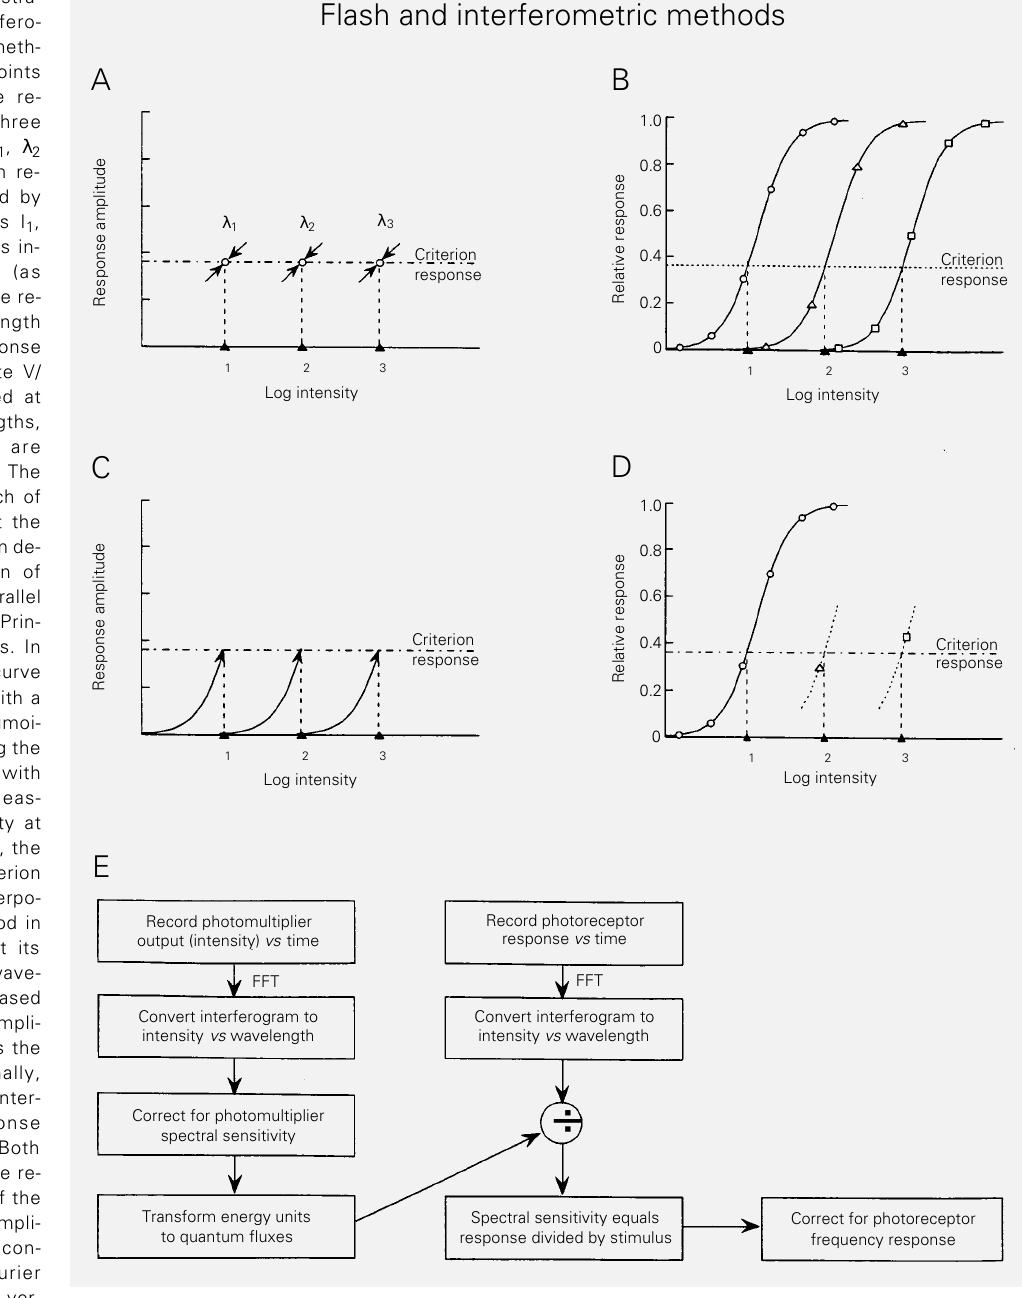
Figure 2 - Schematic illustra- tions of flash and interfero- metric, linear-response meth- ods. In A-D , the three points or curves represent the re- sponse amplitudes at three different wavelengths, l 1 , l 2 and l 3 , with the criterion re- sponse amplitude elicited by three different intensities I 1 , I 2 and I 3 . In A , intensity is in- creased or decreased (as shown by arrows) until the re- sponse at each wavelength equals the criterion response amplitude. In B , complete V/ logI curves are measured at three different wavelengths, and sigmoidal curves are drawn through the points. The intensities needed at each of the wavelengths to elicit the criterion response are then de- termined by interpolation of the sigmoidal curves. Parallel curves indicate that the Prin- ciple of Univariance holds. In D , one complete V/logI curve is measured and fitted with a sigmoidal curve. This sigmoi- dal curve is then slid along the intensity axis to coincide with response amplitudes meas- ured at only one intensity at each wavelength. As in B , the intensity needed for a criterion response is found by interpo- lation. In the ramp method in C , the intensity starts at its lowest value at each wave- length and then is increased continuously until the ampli- tude of response reaches the criterion amplitude. Finally, the steps involved in the inter- ferometric, linear-response method are shown in E . Both response and intensity are re- corded during scanning of the interferometer, and the ampli- tudes versus time are con- verted by the Fast Fourier Transform to amplitudes ver- sus wavelength. The intensities are corrected for the spectral sensitivity of the photomultiplier and are converted into quantum fluxes. Dividing the response by the intensity yields the spectral sensitivity, which may need to be corrected for the photoreceptor frequency response (since wavelengths are coded as frequencies in the